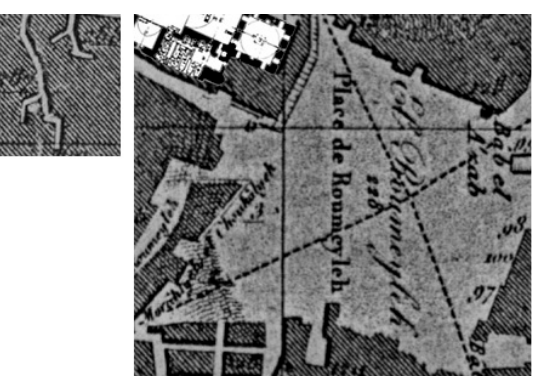
Fig. 2. Typology of urban spaces in historic Cairo: Linear and central spaces, examples